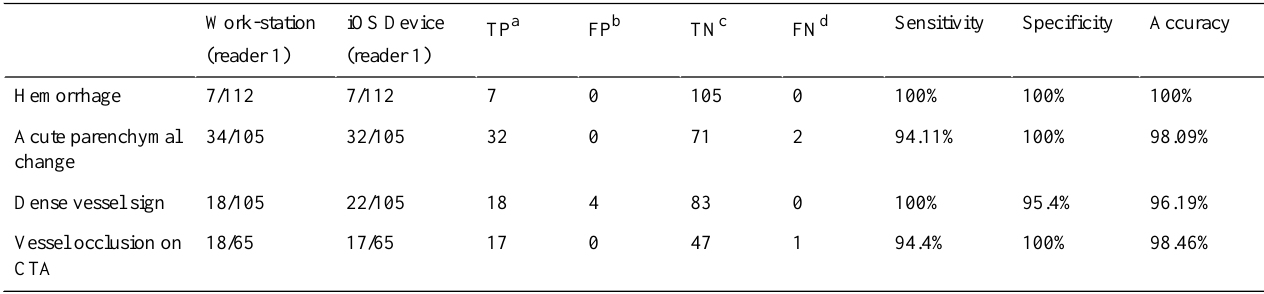
Table 1. Sensitivity, specificity, and accuracy of stroke diagnosis using the client-server teleradiology system by reader